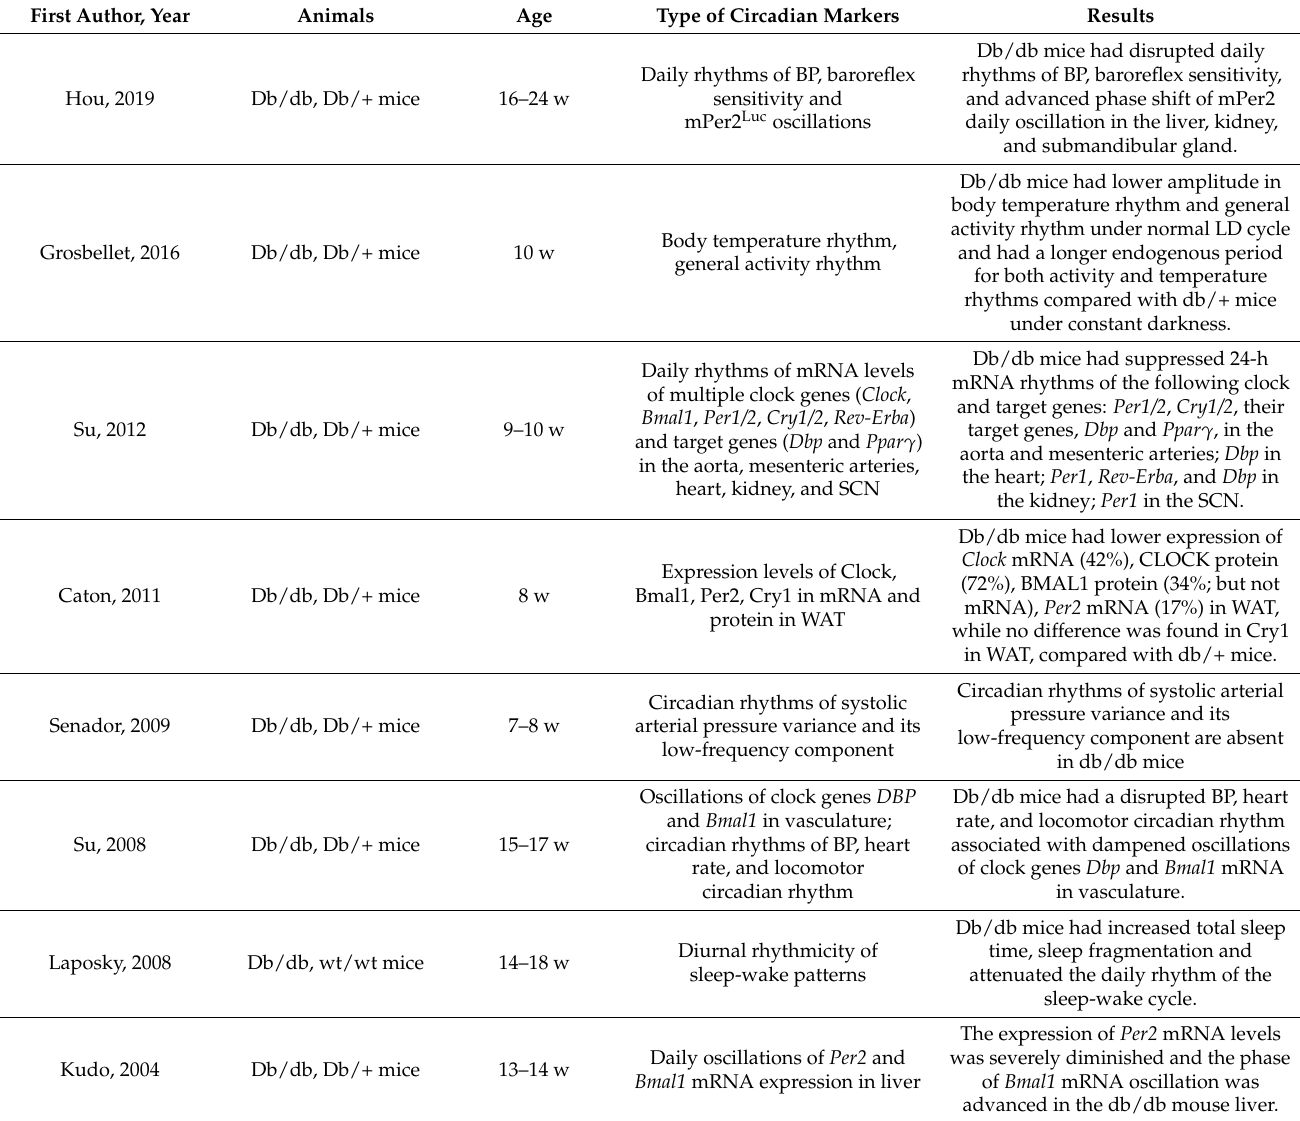
Table 1. Circadian rhythm disruptions among diabetic animal